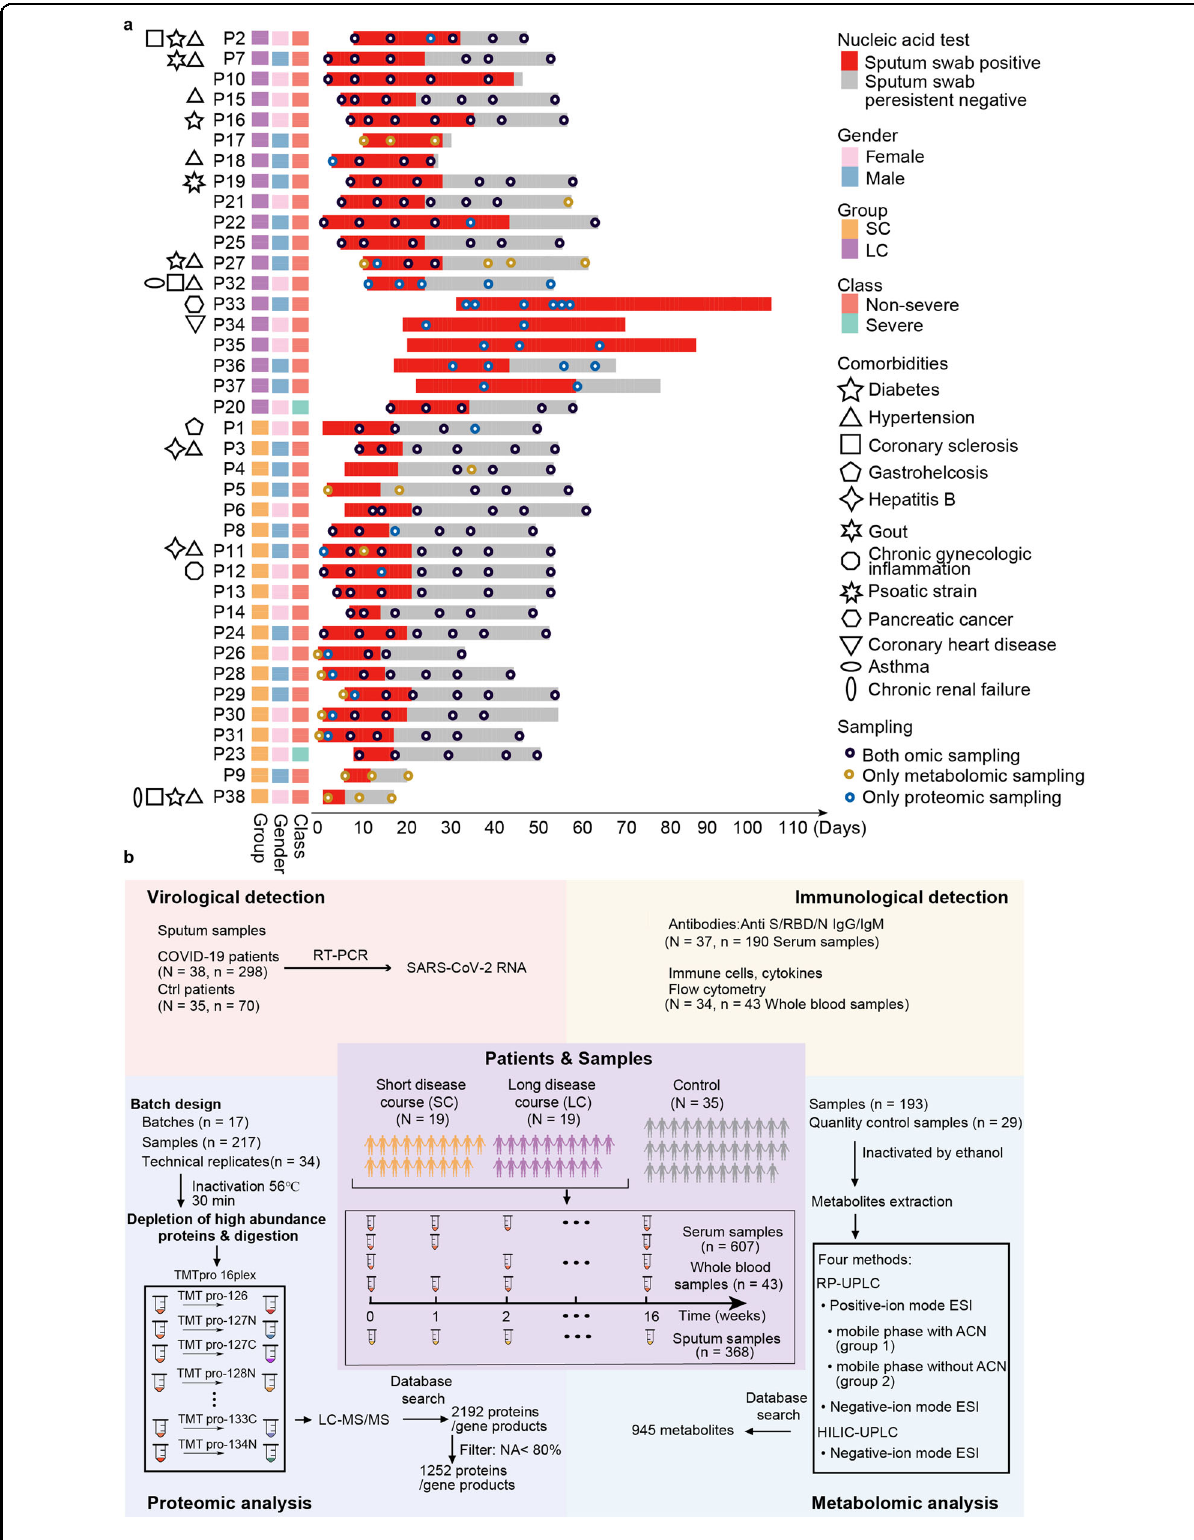
Fig. 1 (See legend on next